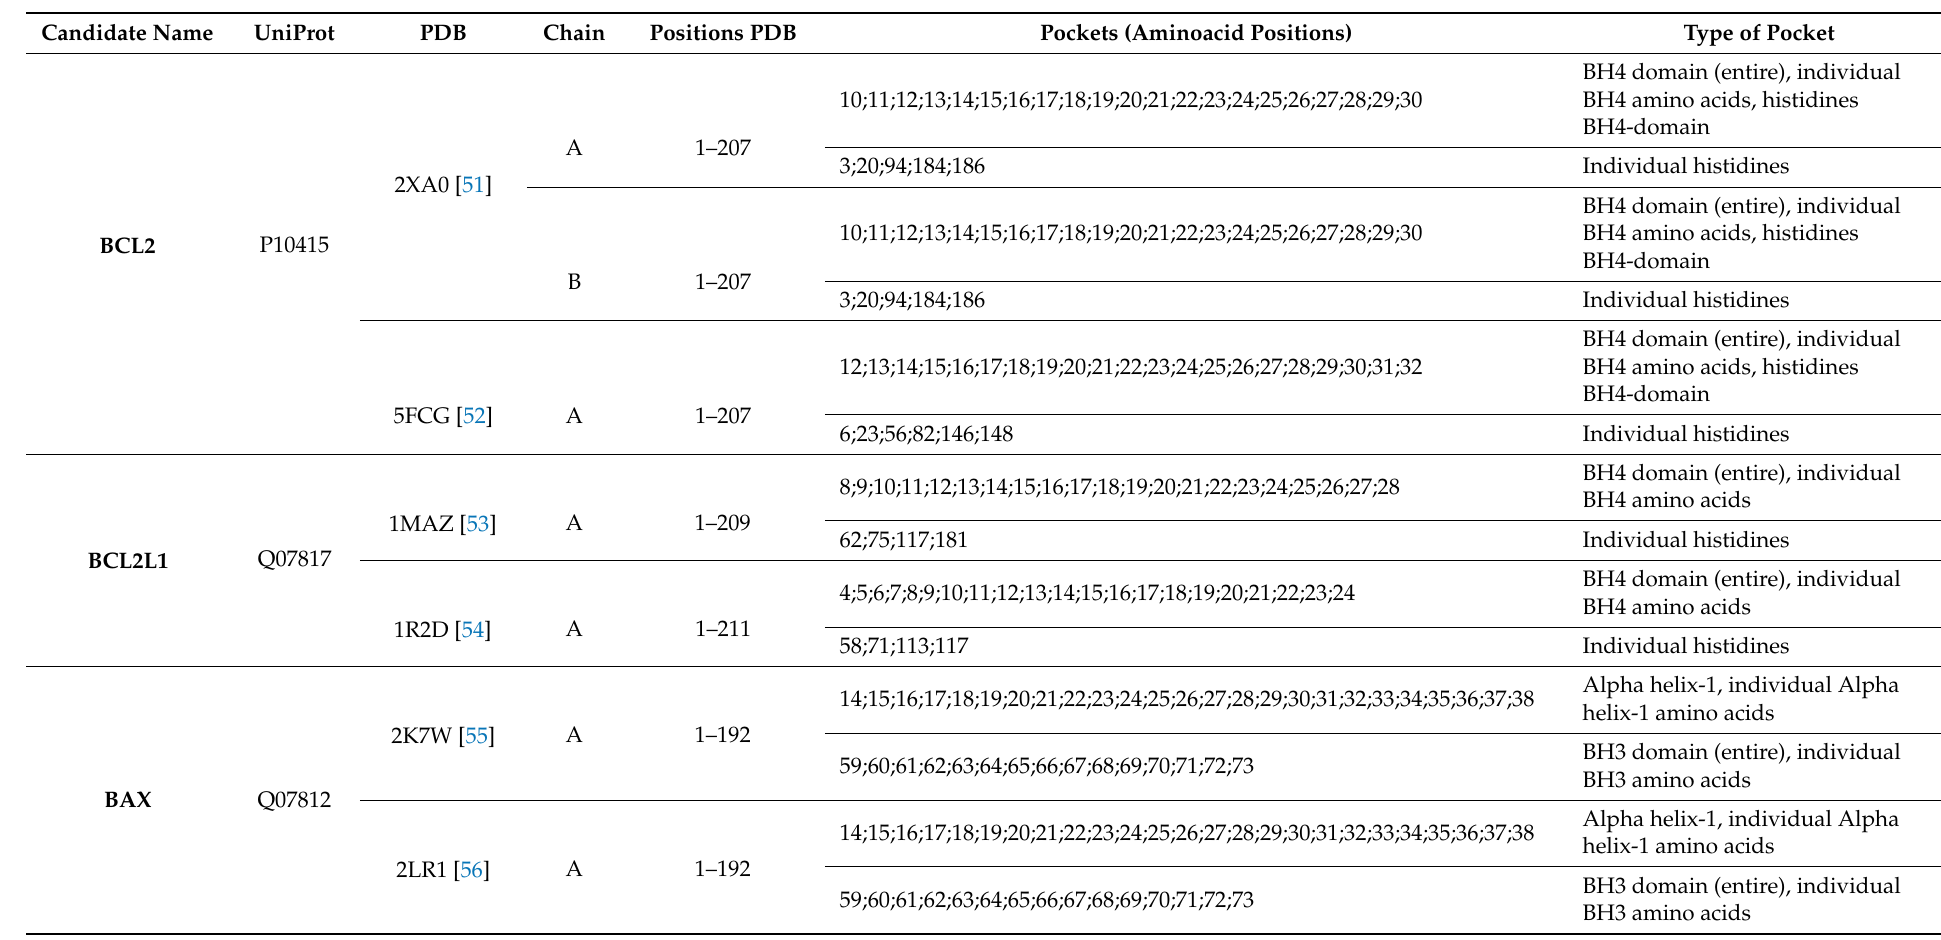
Table 1. Structures and pockets used for docking